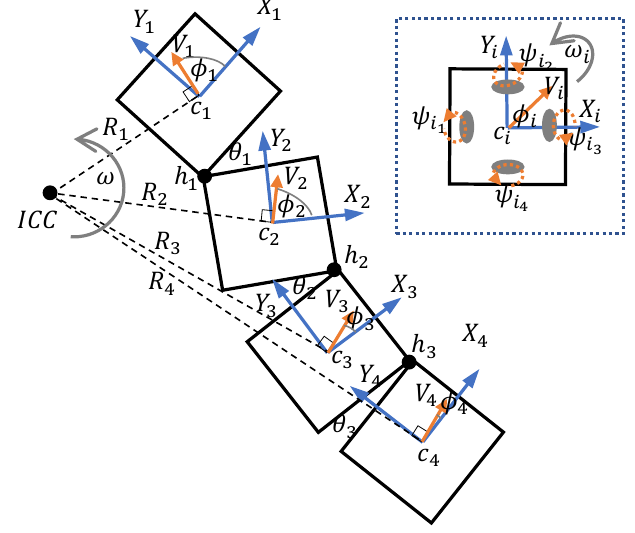
Figure 3. Locomotion kinematic model of the